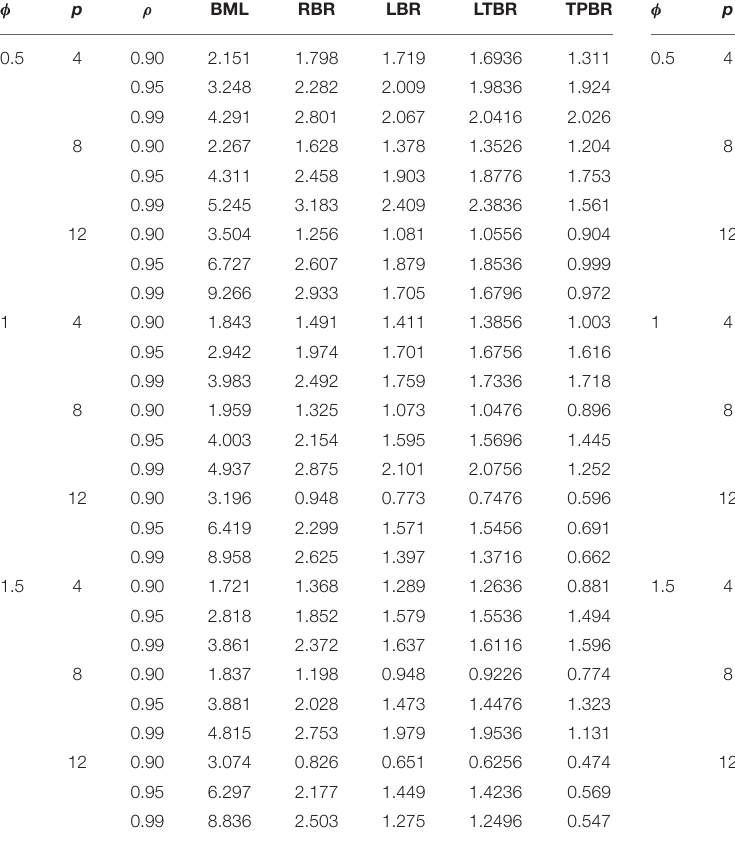
250. TABLE 4 | Mean squared error values for different estimators when n =